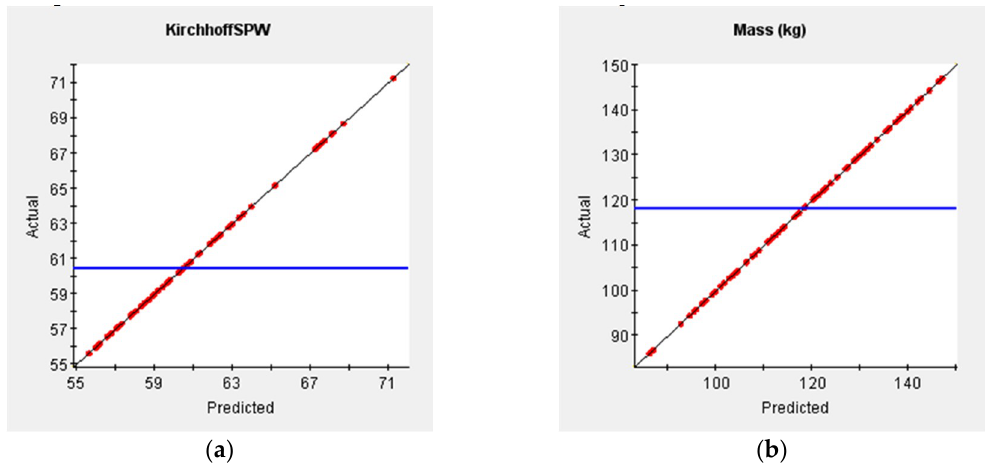
Figure 21. The error schematic diagram of each response surface model. ( a ) The precision of sound power on the volute surface; ( b ) The precision of total mass.